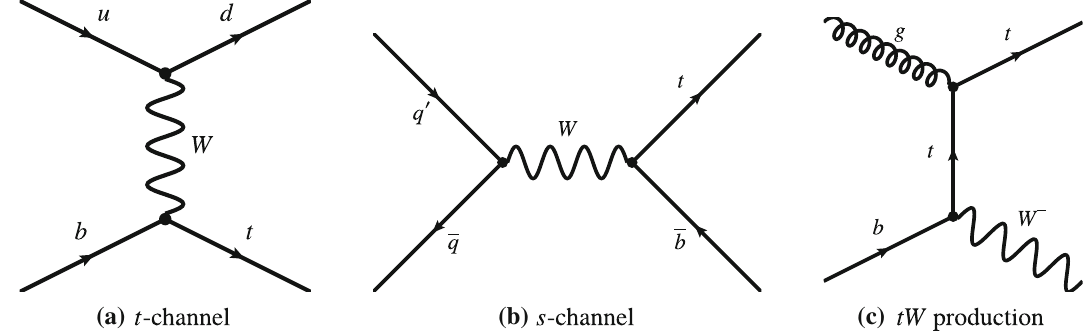
Fig. 1 Example LO Feynman diagrams of single top-quark production: a t -channel, b s -channel and c tW